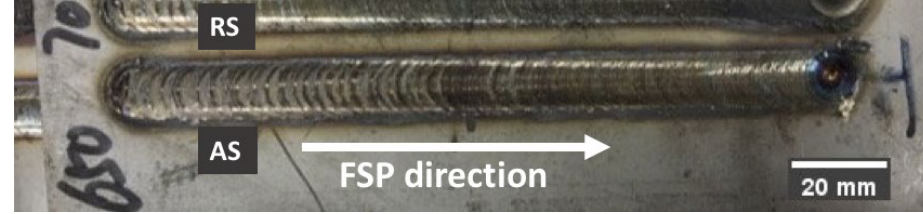
Figure 1. Top view of FSPed SAF 2507.